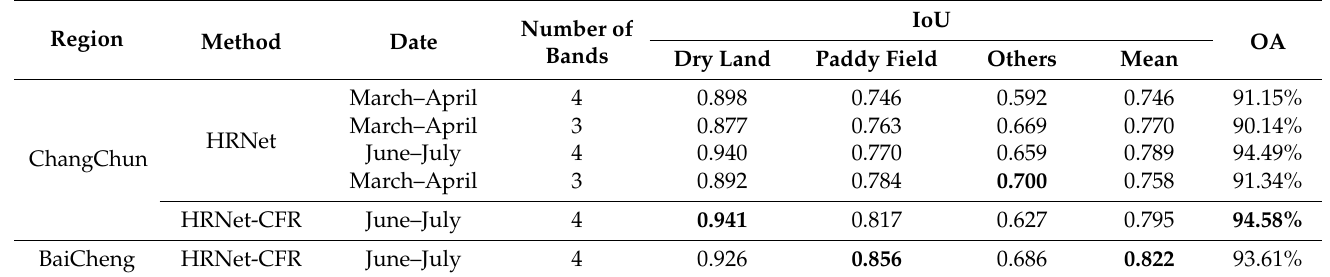
Table 2. Accuracy evaluation of cropland extraction from multi-region and multi-temporal high- resolution remote sensing images by Jilin-1. Note: the best performance is marked as